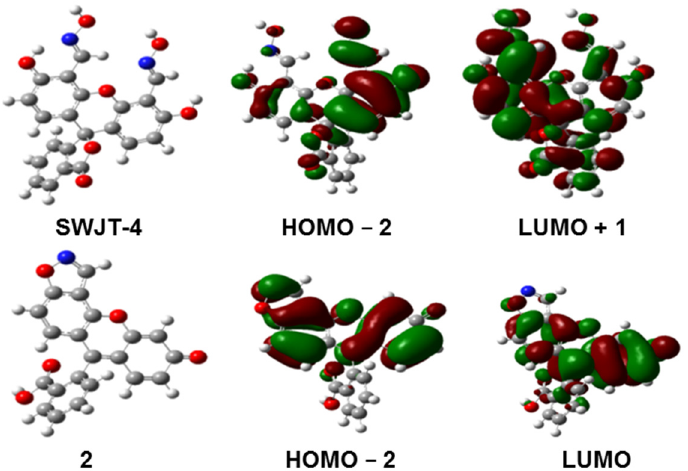
Figure 4. The optimized structures and the molecular orbital plots of SWJT-4 and 2